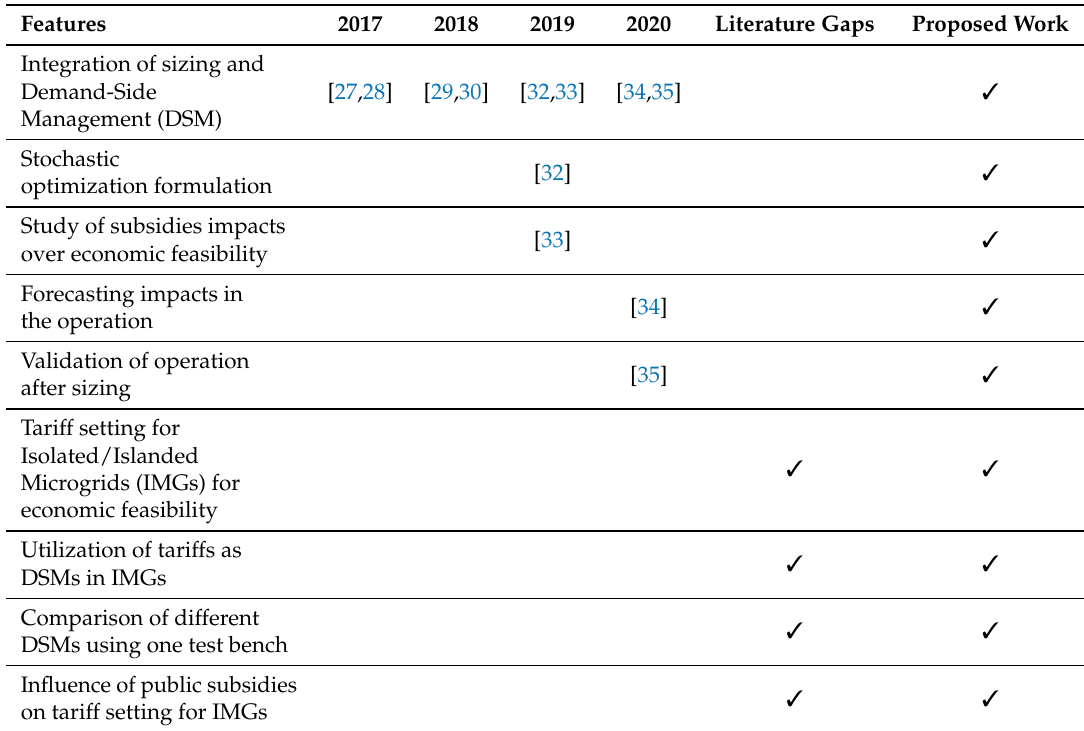
Table 1. Summary of the literature